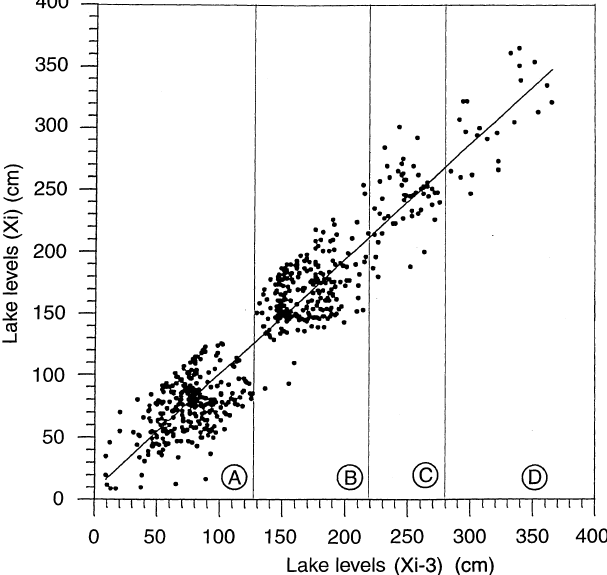
Fig. 6. Lag-three water level fluctuations and cluster boundaries